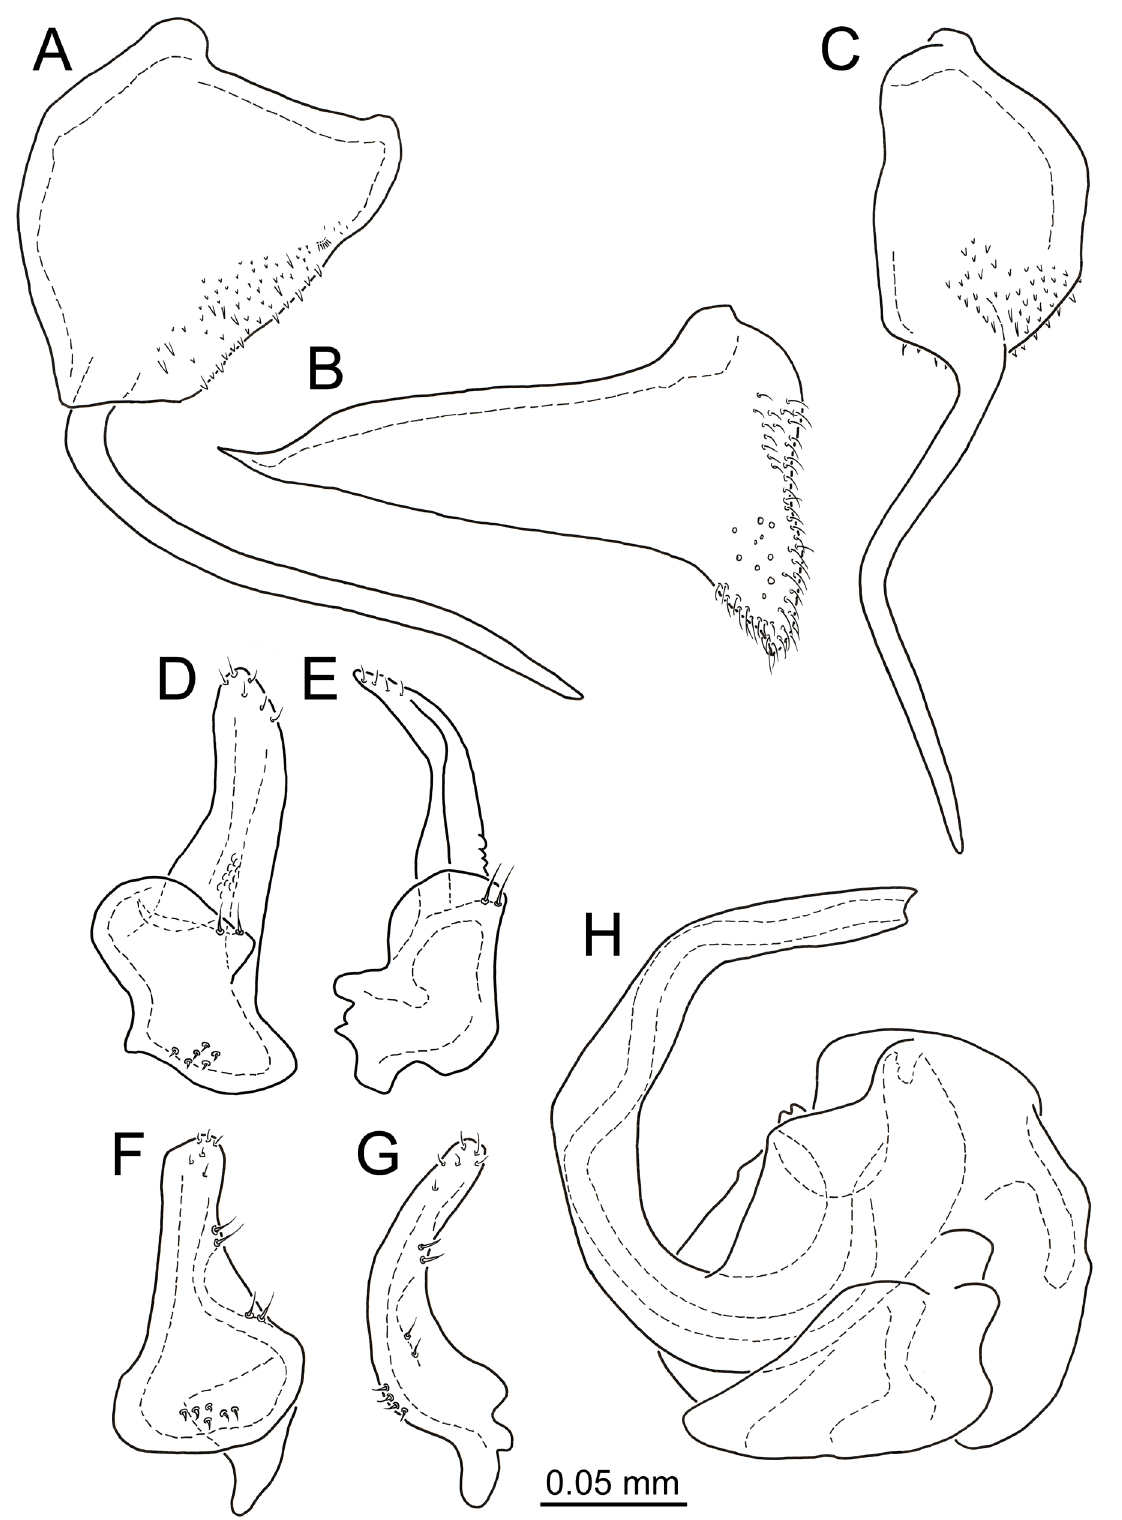
Fig. 16. Kokeshia pengae sp. nov., segment VIII and genitalia, paratype, ♂ (SYSBM). A, C . Left hemitergite VIII. A . Dorsal view. C . Left lateral view. B . Right hemitergite VIII, dorsal view. D‒E . Left paramere, two different aspects. F‒G . Right paramere, two different aspects. H .